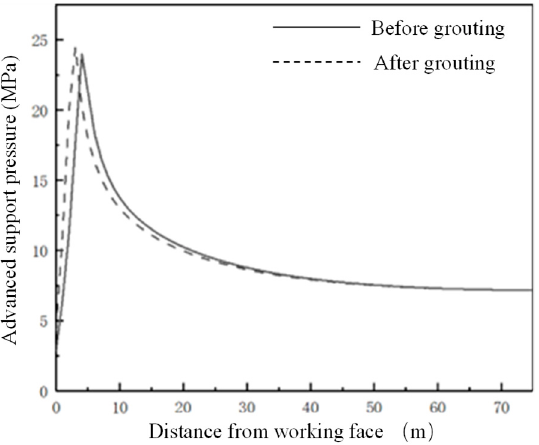
Figure 10. Comparison of advanced abutment pressure before and after grouting.